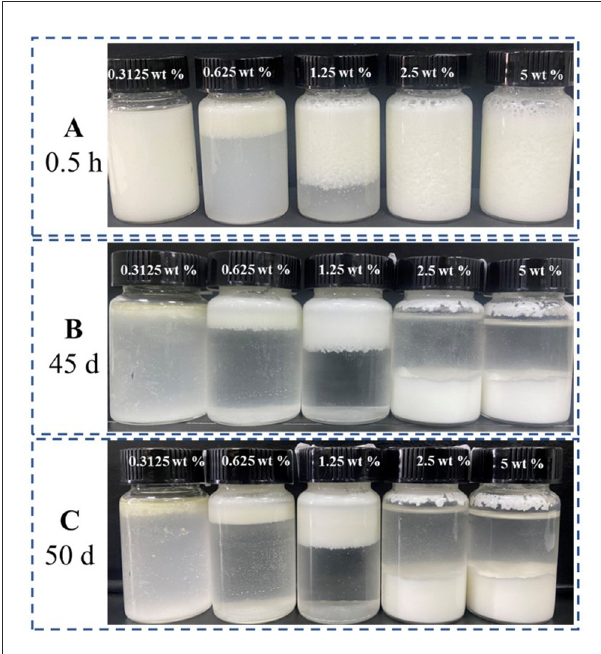
FIGURE1 Storage stability of GO/ β -CD emulsion (A) for 0.5h, (B) for 45d, and (C) for